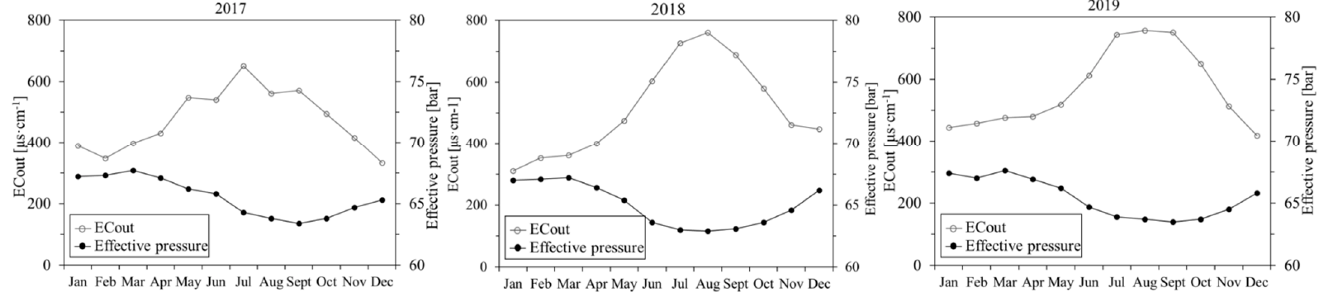
Figure 5. Annual evolution of permeate water electric conductivity (ECout) and effective pressure in 2017, 2018 and 2019.